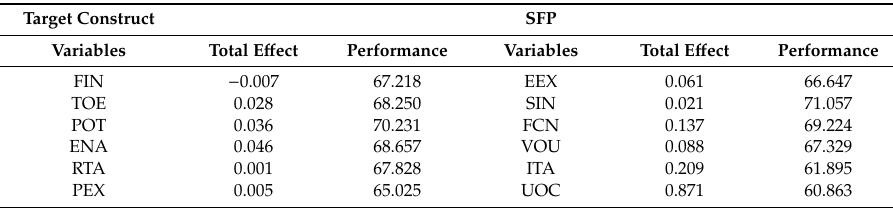
Table 6. Importance-Performance